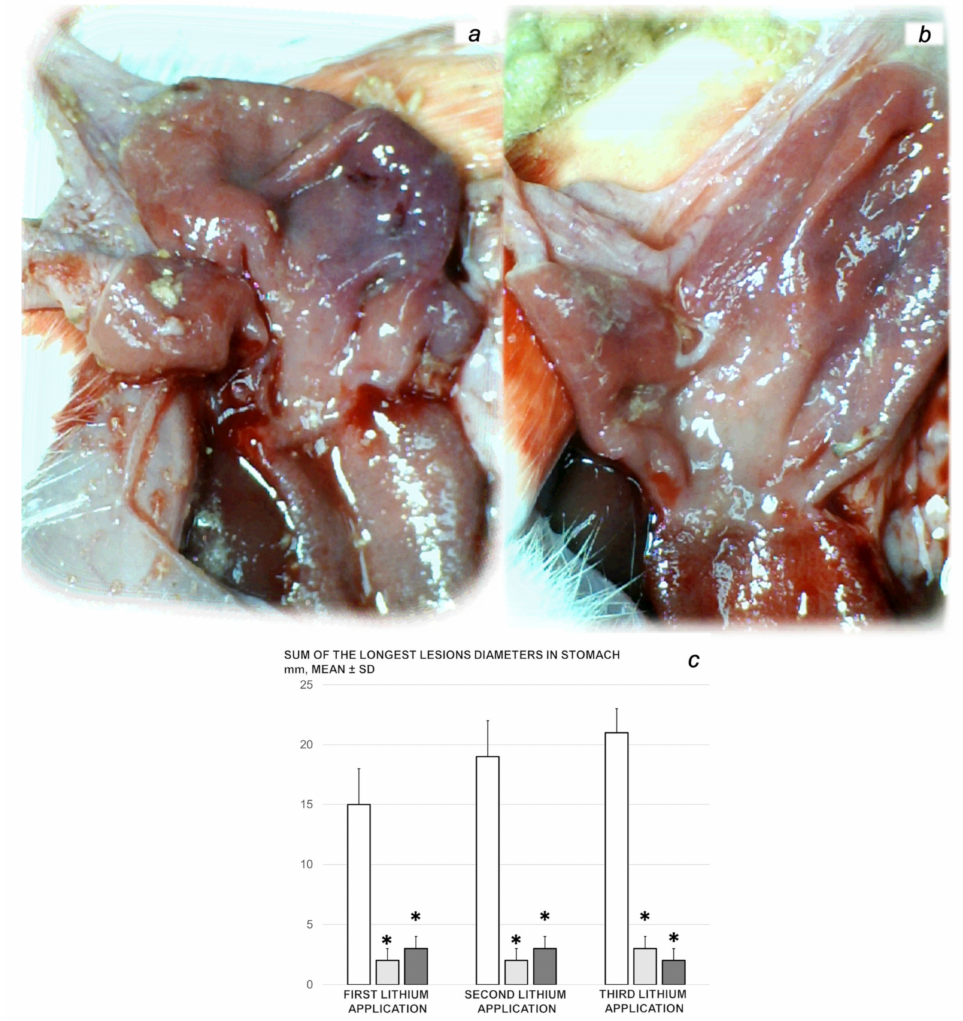
Figure 8. Illustrative gross gastrointestinal lesions in the stomach of the lithium-treated rats after the first lithium adminis- tration ( a ) and presentation close to normal in lithium-treated rats that received BPC 157 after lithium administration ( b ). ( c ) Mucosal lesions in the stomach (sum of the longest lesions diameters, mm, means ± SD) after the first, second, and third lithium administrations (500 mg/kg/day, intraperitoneally, for 3 consecutive days). BPC 157 10 µ g/kg (light gray bars), 10 ng/kg (dark gray bars); saline 5 mL/kg (white bars) given intraperitoneally after each of the lithium administrations. Six rats/group/interval. * p < 0.05, at least, vs.